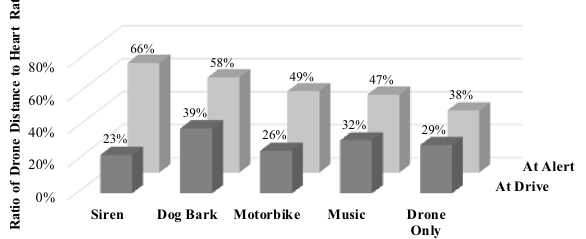
Figure 4. Tradeoff for different sound effects between good distance and low heart